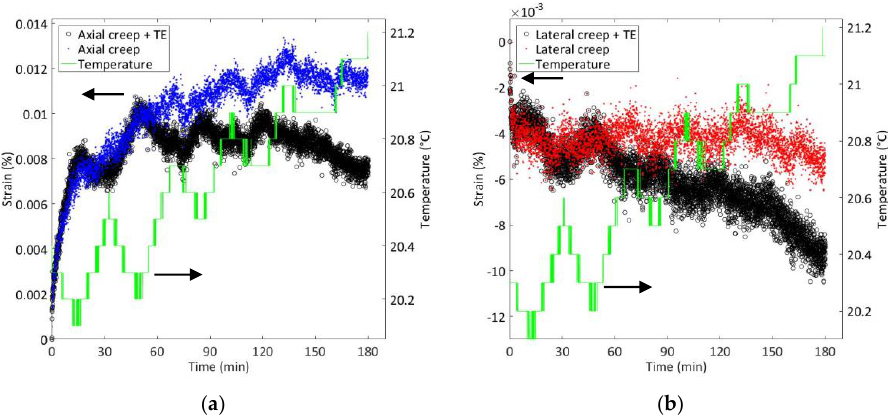
Figure 4. ( a ) Axial and ( b ) lateral creep deformations of LSCF-P5 sample for 3 h under 25-MPa maximum stress superimposed with a temperature measurement during the experiment.